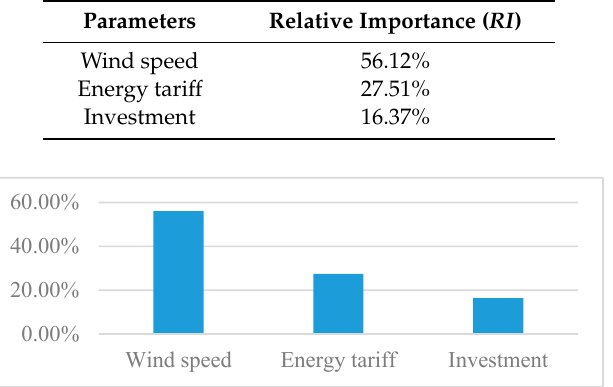
Table 2. Representation of the Relative Importance ( RI ) of the parameters in the NPV value.